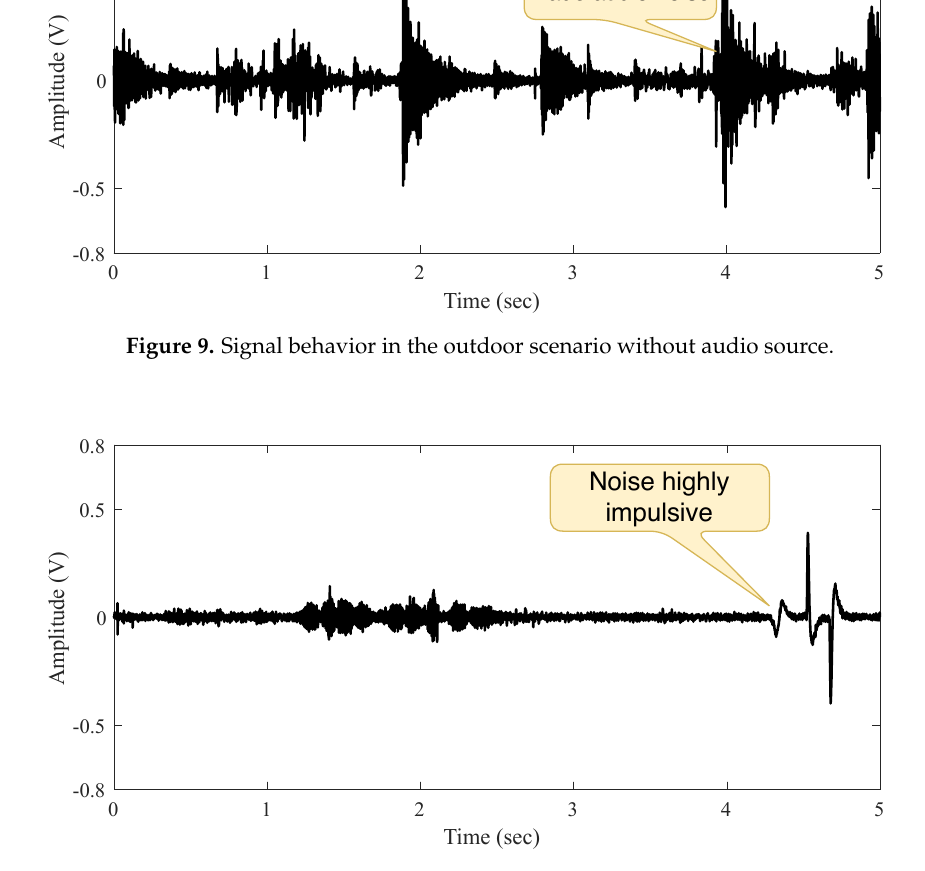
Figure 10. Signal behavior in the outdoor scenario with a person moving and